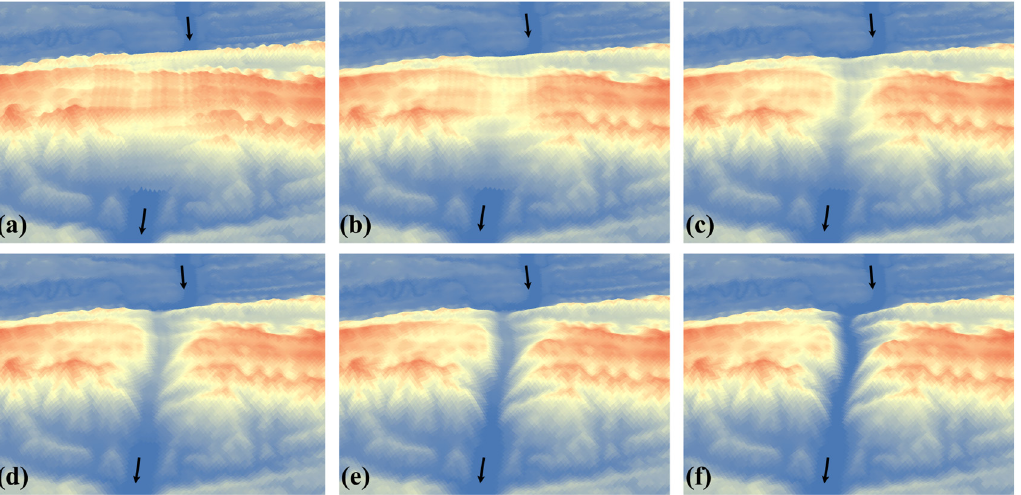
Figure 20. Headward erosion process of a transverse canyon ③ . ( a ) The reconstructed paleotopography; ( b – e ) the intermediate process of headward erosion; and ( f ) the current terrain. Black arrows represent flow direction.